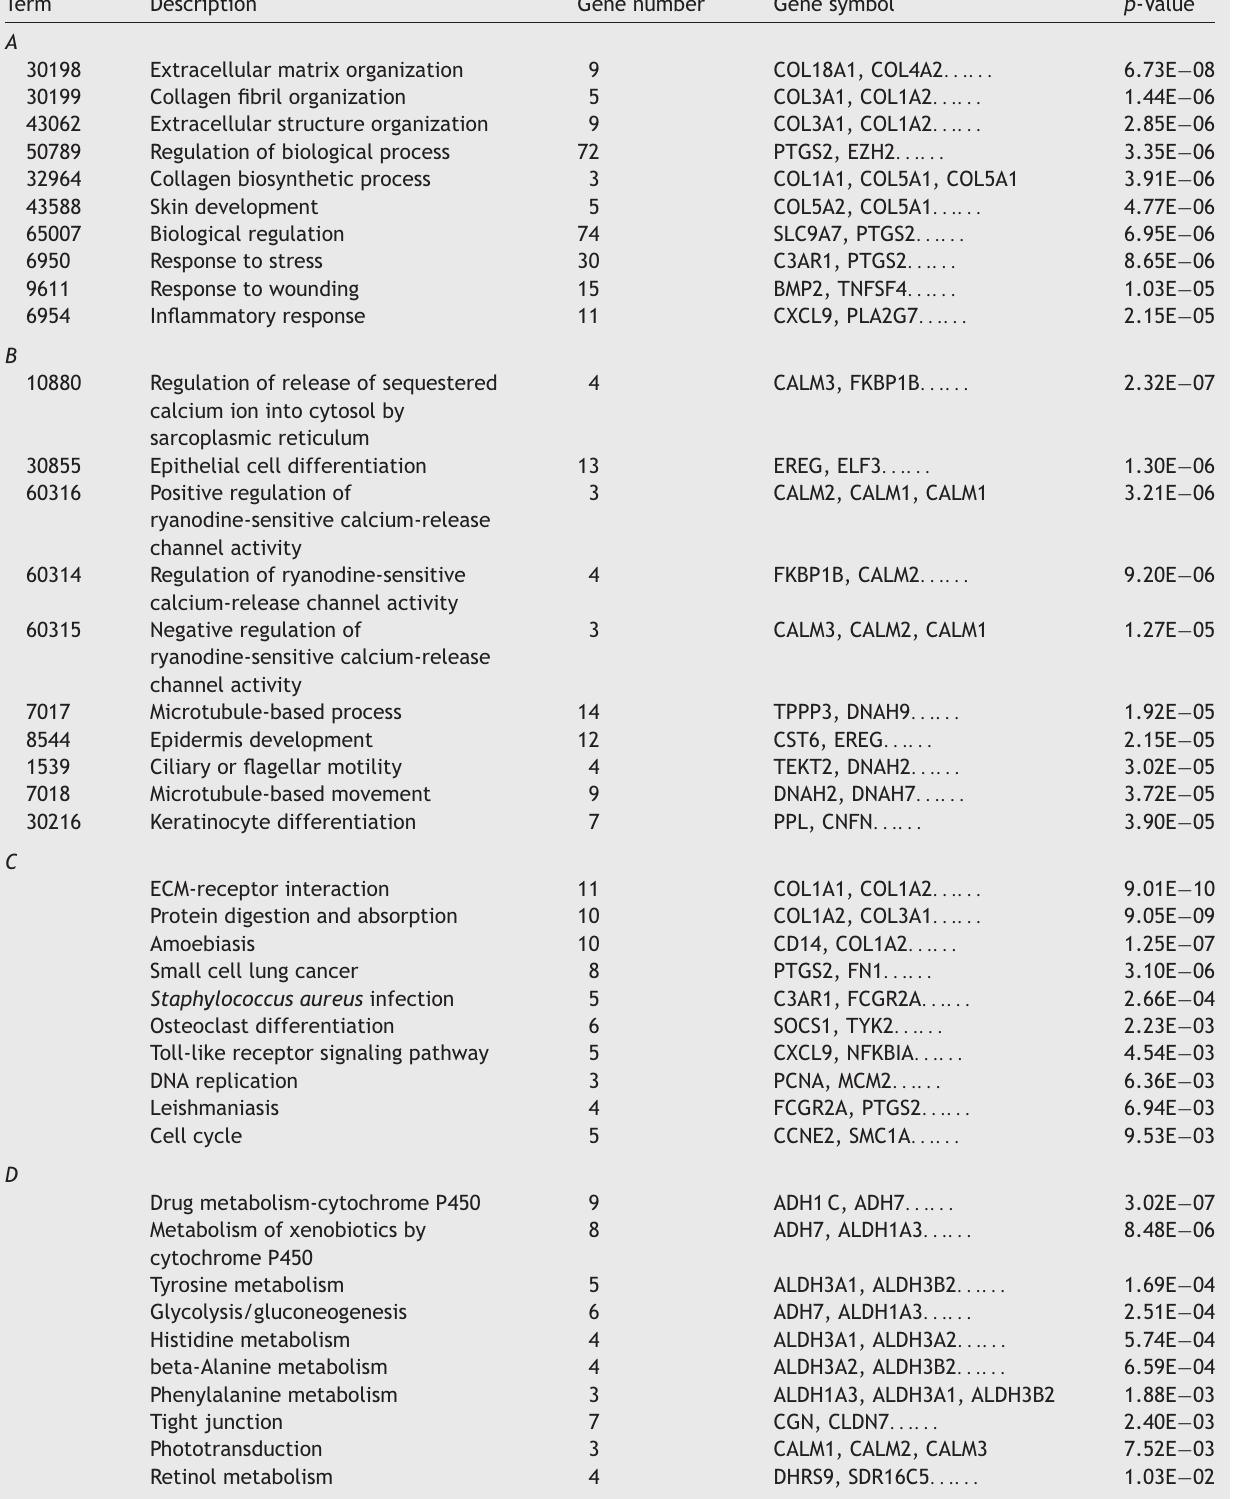
Table 1 The enriched GO functions and KEGG pathways for the up-regulated and the down-regulated genes. (A) The top 10 GO functions enriched for the up-regulated genes. (B) The top 10 GO functions enriched for the down-regulated genes. (C) The top 10 KEGG pathways enriched for the up-regulated genes. (D) The top 10 KEGG pathways enriched for the down-regulated